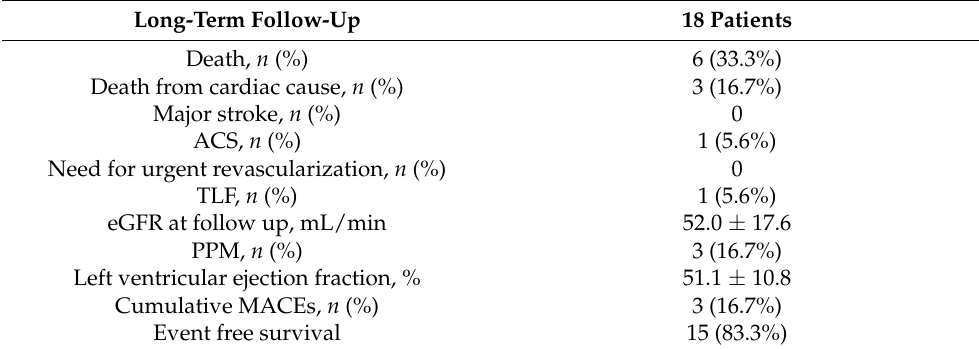
Table 4. Long term follow-up